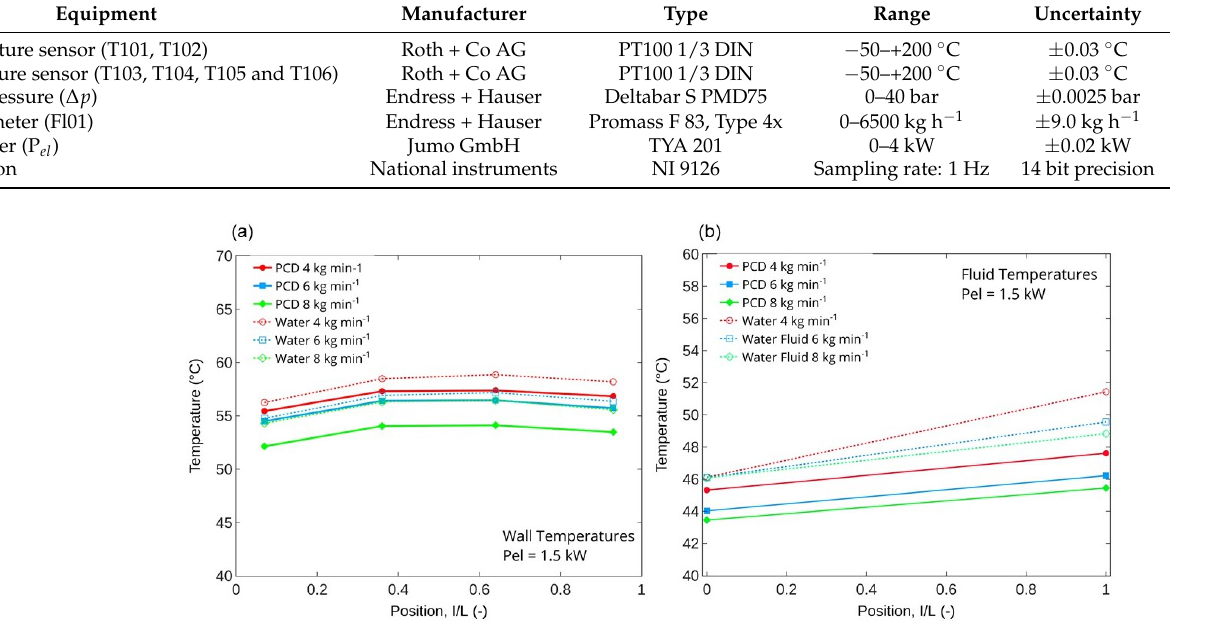
Figure 5. Comparing the temperatures of the PCD and water for an electrical heating input of 1.5 kW and at three different mass flow rates (4, 6 and 8 kg min − 1 ) as a function of the dimensionless position for ( a ) the wall temperatures and ( b ) the bulk fluid inlet and outlet